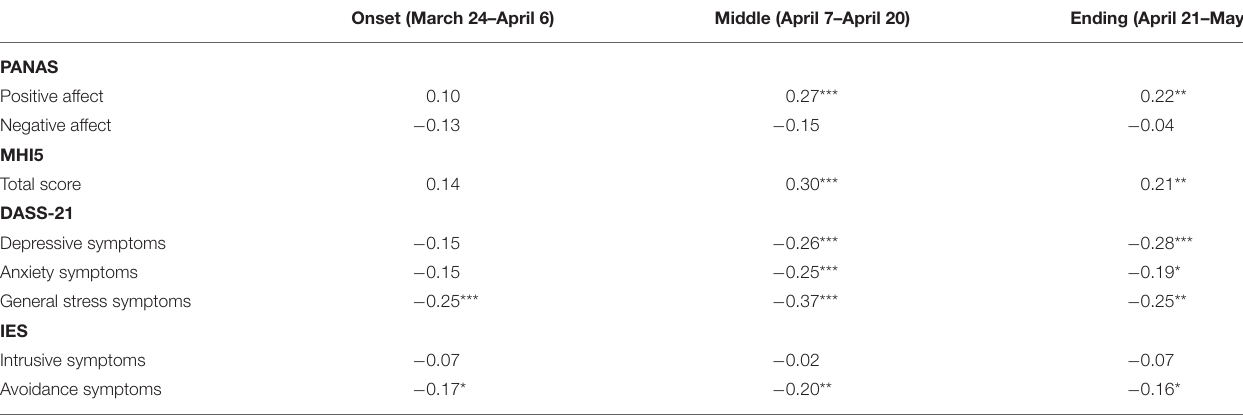
TABLE 2 | Spearman correlations between the age and the psychological measures.